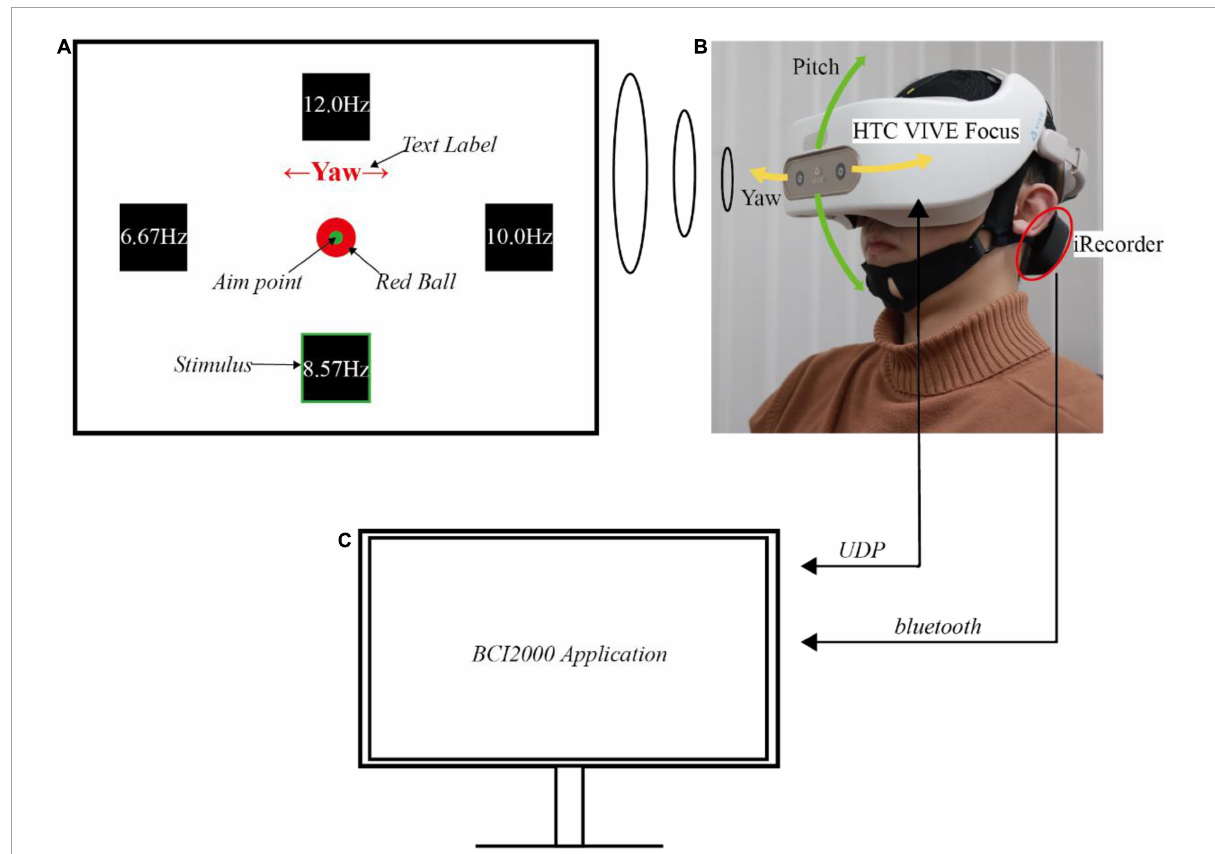
FIGURE1 The experimental setup. (A) Illustration of the user interfaces in virtual reality. (B) Demonstration of a subject performing the experiment. (C) Illustration of the computer and its wireless